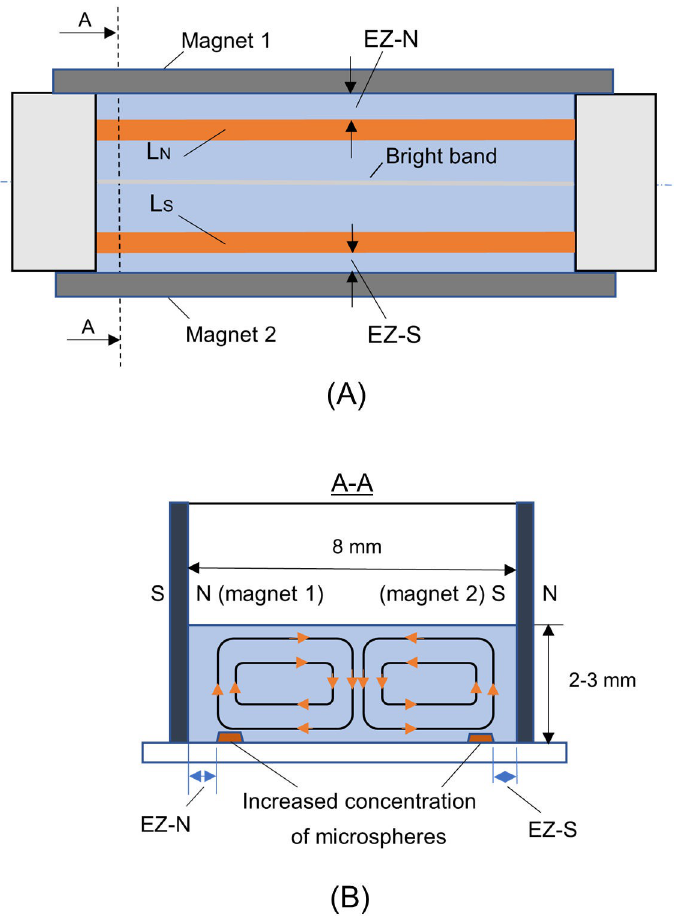
Fig 5. Schematic drawing of experimental Setup 2. (A) Exclusion zones, EZ-N and EZ-S formed near poles of magnets 1 and 2. L N , L S --layers of increased microsphere concentration near North (N) and South (S) poles. (B) Oval closed lines show the patterns of movement of microspheres. A bright microsphere-free band (width 30–200 μ m), which is located halfway between the magnets, is readily visible under the microscope at all depths of the water